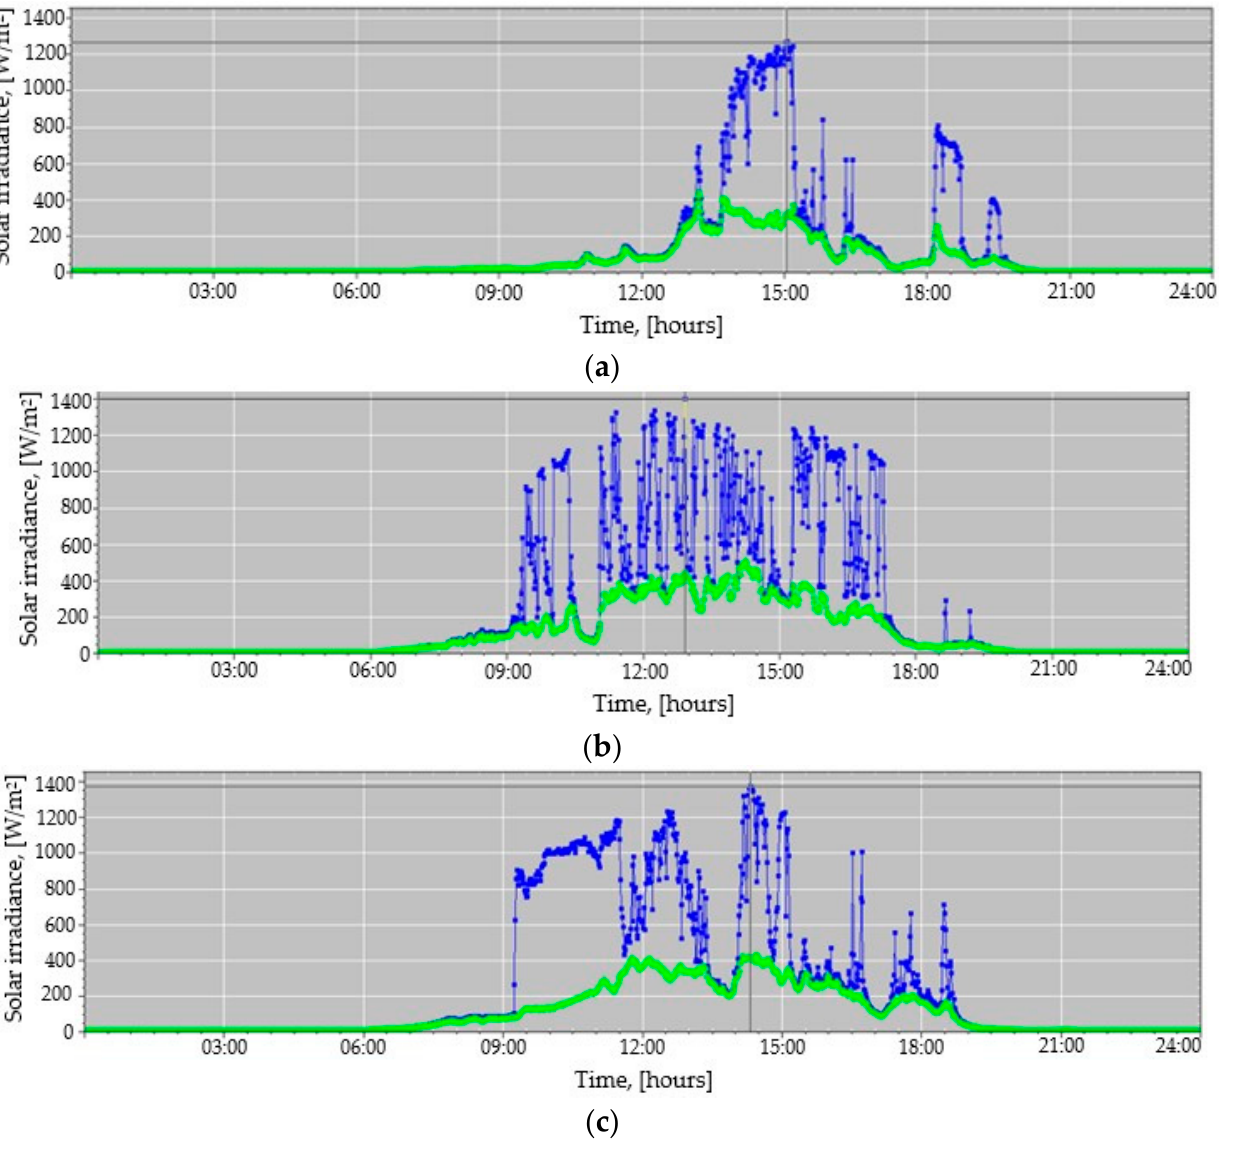
Table 4. The amount of energy used for consumption—Third scenario.